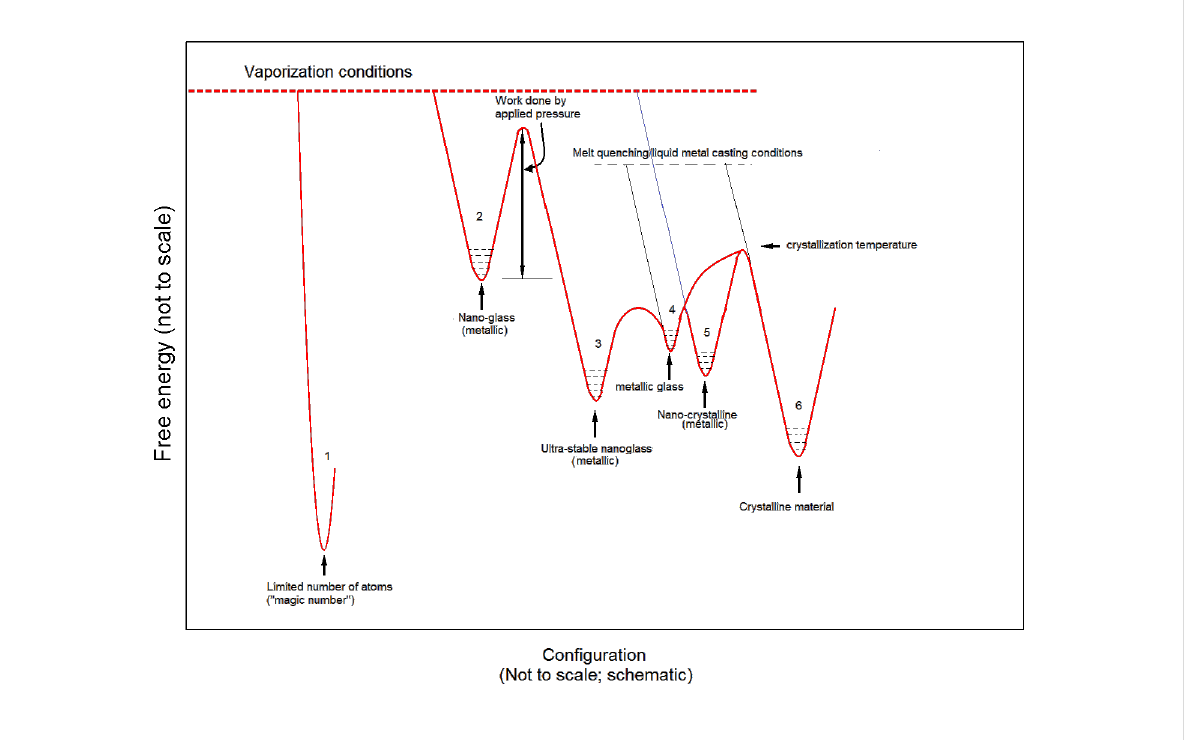
Figure 3: Schematic representation of phase transformations in the free energy–configuration space.